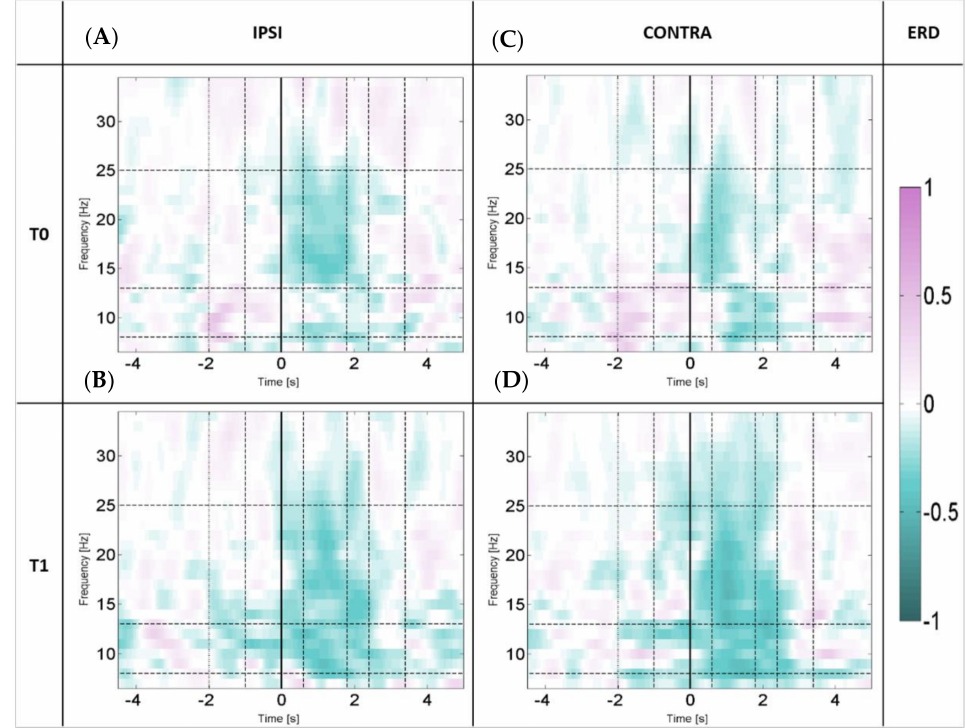
Figure 5. The average maps representing the time-frequency distribution of the ERDi ( A , B ) and the ERDc ( C , D ) before treatment (T0, A – C ) and after robotic rehabilitation (T1, B – D ) are shown. A color legend, on the right of each scheme, identifies the corresponding ERD intensity. The baseline [ − 4.5 s, − 2 s], the pre-movement [ − 1 s, 0 s] the central part of the movement [0.6 s, 1.8 s] and the post-movement [2.4 s, 3.4 s] windows along with the alpha [8 Hz–13 Hz] and beta [13 Hz–25 Hz] bands, are delimited by dashed lines perpendicular to the x and y axis,